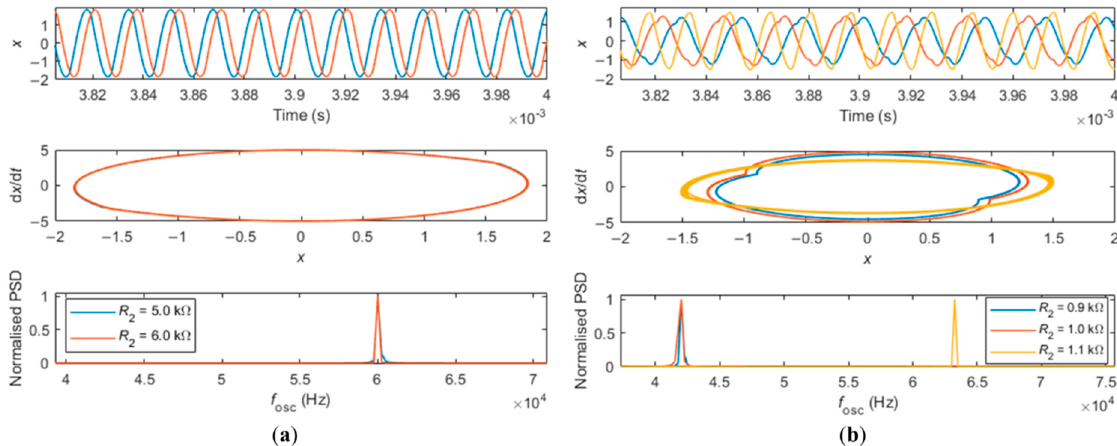
Figure 3. Solving system of Equation (10) for different values of increasing R 2 , for the case of the cantilever oscillating in water. ( a ) Top, middle, and bottom rows show the time deflection, phase space, and normalized Power Spectral Density (PSD) of the signals far from the jump region for different values of R 2 , respectively. ( b ) Time deflection, phase space, and normalized Power Spectral Density (PSD) of the signals close to the jump region, for different values of R 2 .